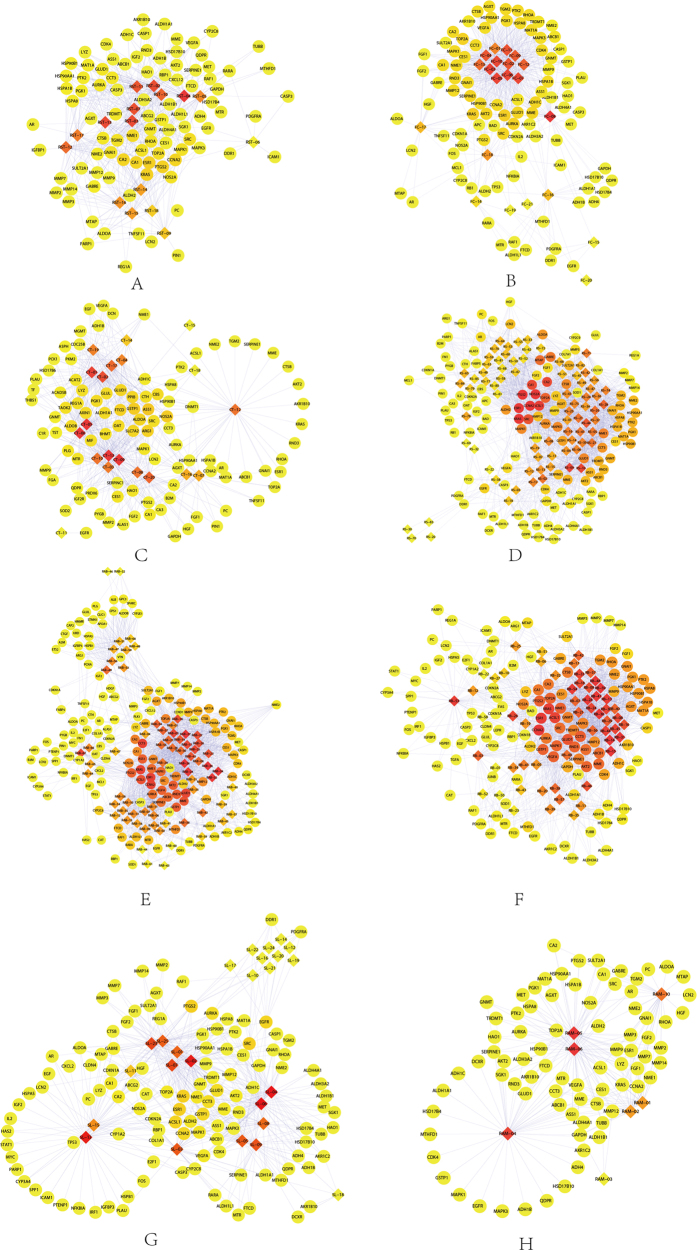
The ingredient-target networks of (A) RST, (B) FC, (C) CT, (D) RS, (E) RAB, (F) RB, (G) SL and (H) RAM. The diamond nodes represent ingredients, and the circular nodes represent targets. The colors of the nodes are illustrated from red to yellow in descending order of degree values.